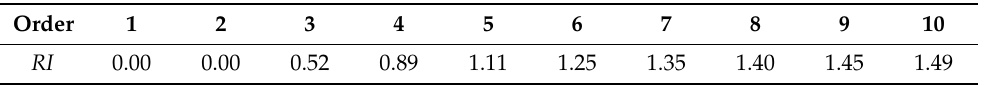
Table 3. Random consistency index ( RI ) ratio of the different values of n [31].